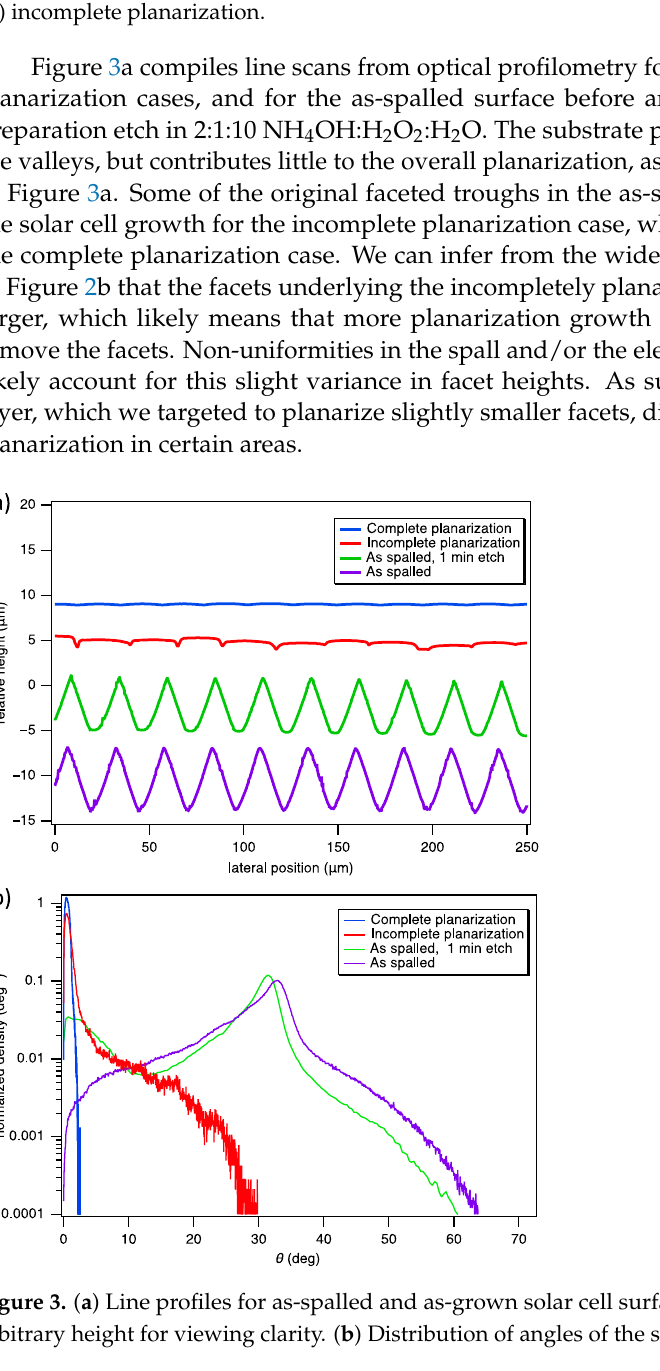
Figure 3. ( a ) Line profiles for as-spalled and as-grown solar cell surfaces. Profiles are separated by arbitrary height for viewing clarity. ( b ) Distribution of angles of the surface normal to the [100].